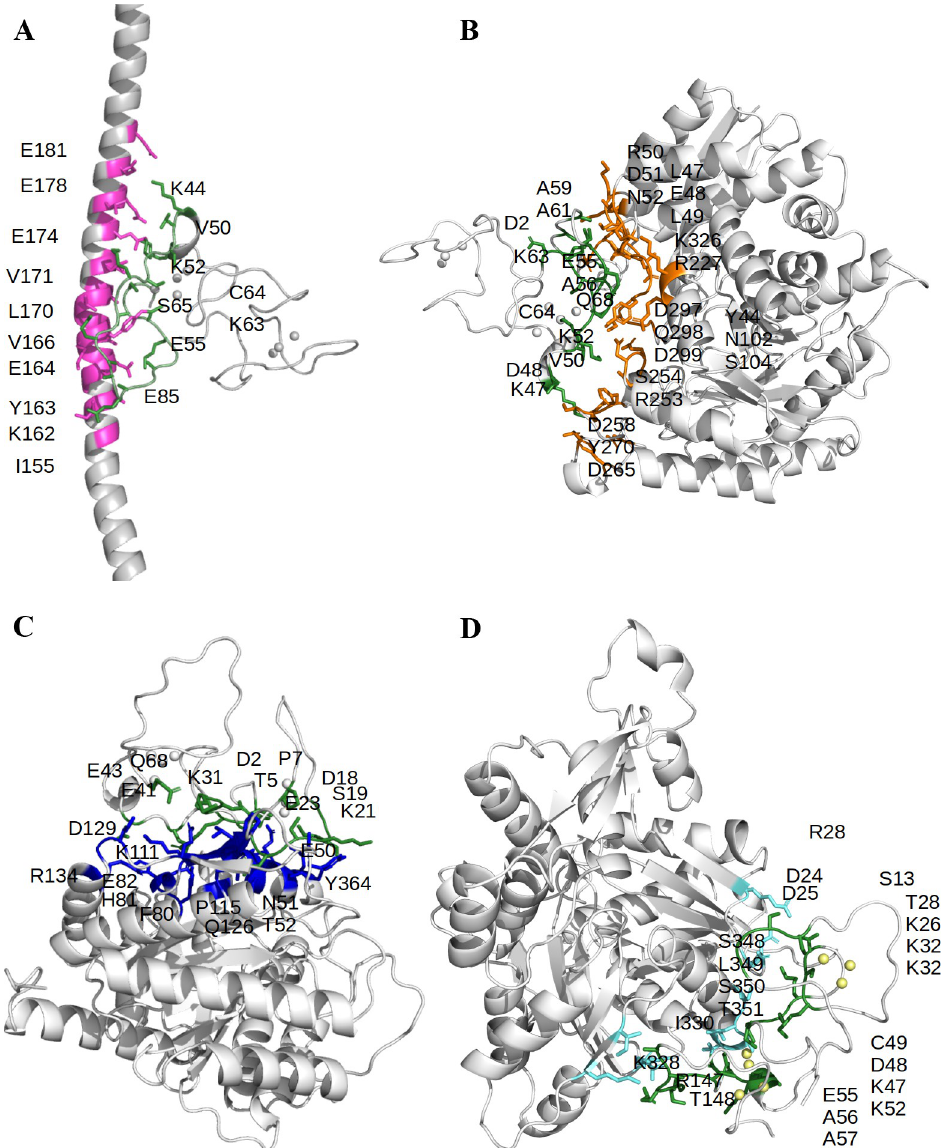
Fig 8. Inter-biomolecular interactions. The surface residues that are taking part in the interactions and making contacts between MT-3 (green) and the proteins (A) tropomyosin 3, B) enolase 1 (C) aldolase A, and (D) β -actin. All residues are colored and